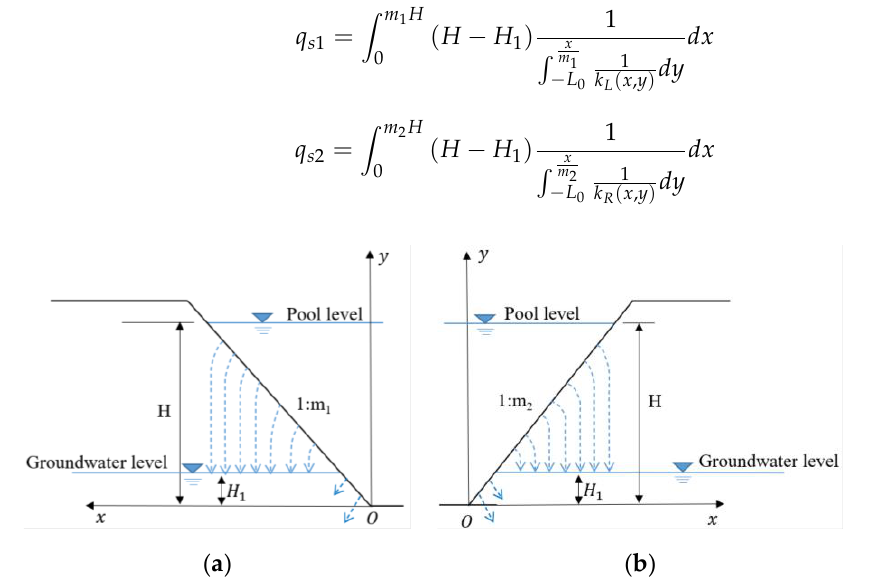
Figure 11. Calculation for leakage from the reservoir periphery. ( a ) Left side. ( b ) Right side.